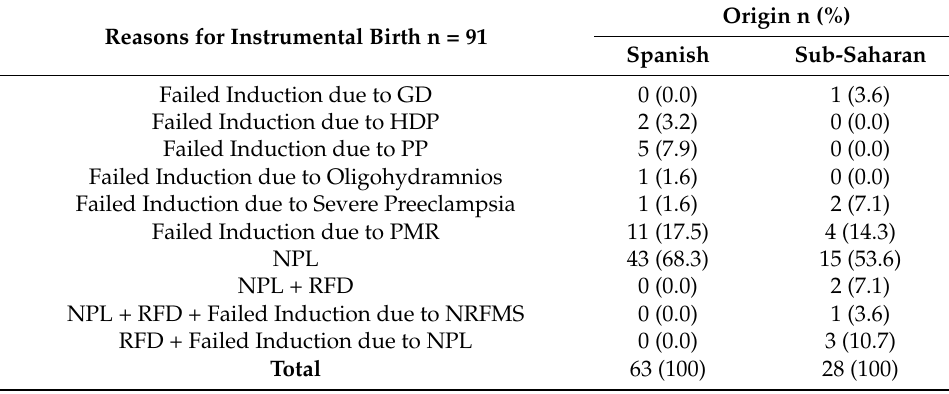
Table 4. Reasons for instrumental births according to origin.